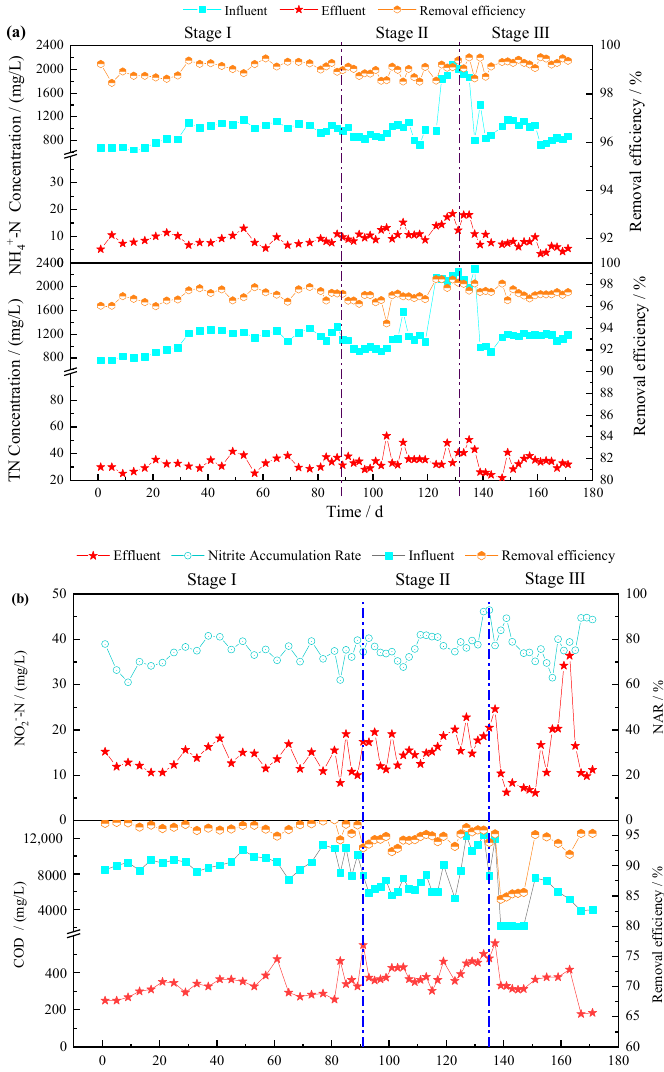
Figure 3. Performance of the SMBR treatment of swine wastewater. ( a ) NH +